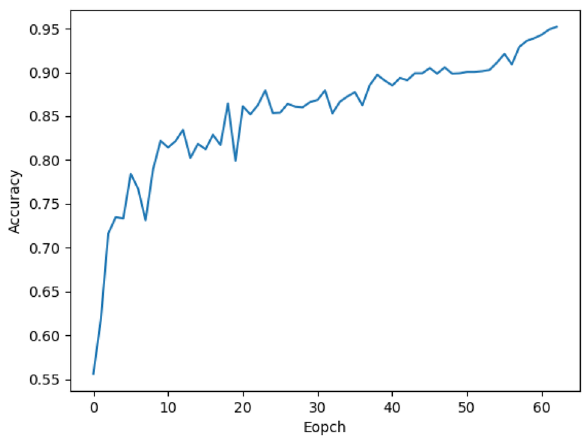
Fig. 11 Accuracy of YOLOv4 against the validation set